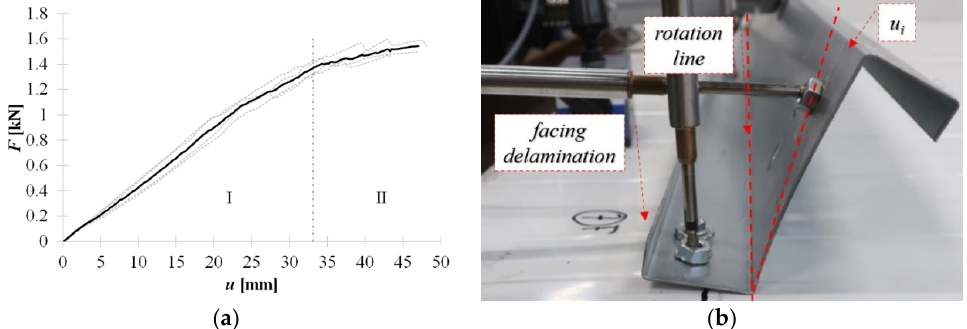
Figure 12. Tightened blind rivet: ( a ) equilibrium load ‐ displacement paths, ( b ) connection behaviour in stage I.